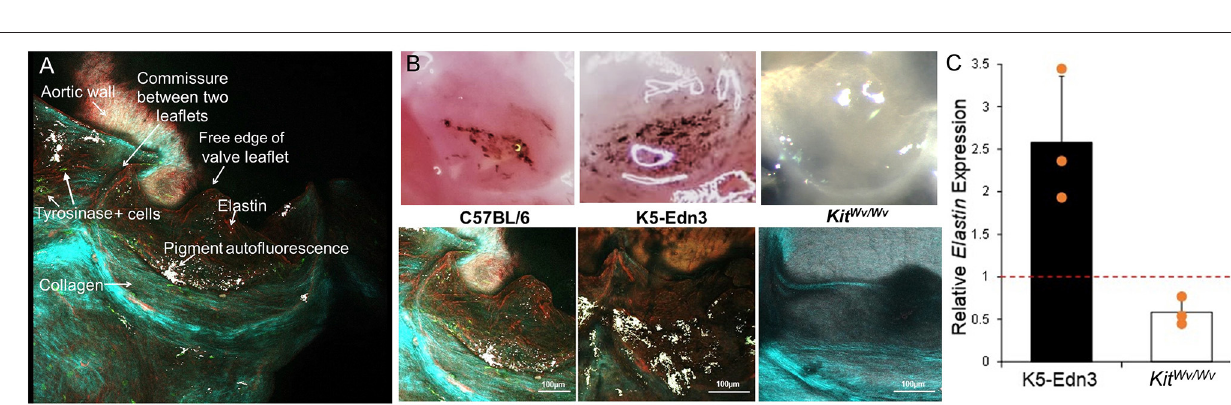
FIGURE 4 | Parallel reaction monitoring proteomics and western blotting on human AV tissue protein lysate and human AV tissue sections for (A) ENO2, (B) GFAP, and (C) TUJ1; Western blotting for each protein [HBC (human brain cortex)] positive control, AV (aortic valve protein). Immunohistochemistry on human AV leaflet sections for each protein. Scale = 100 µ m.